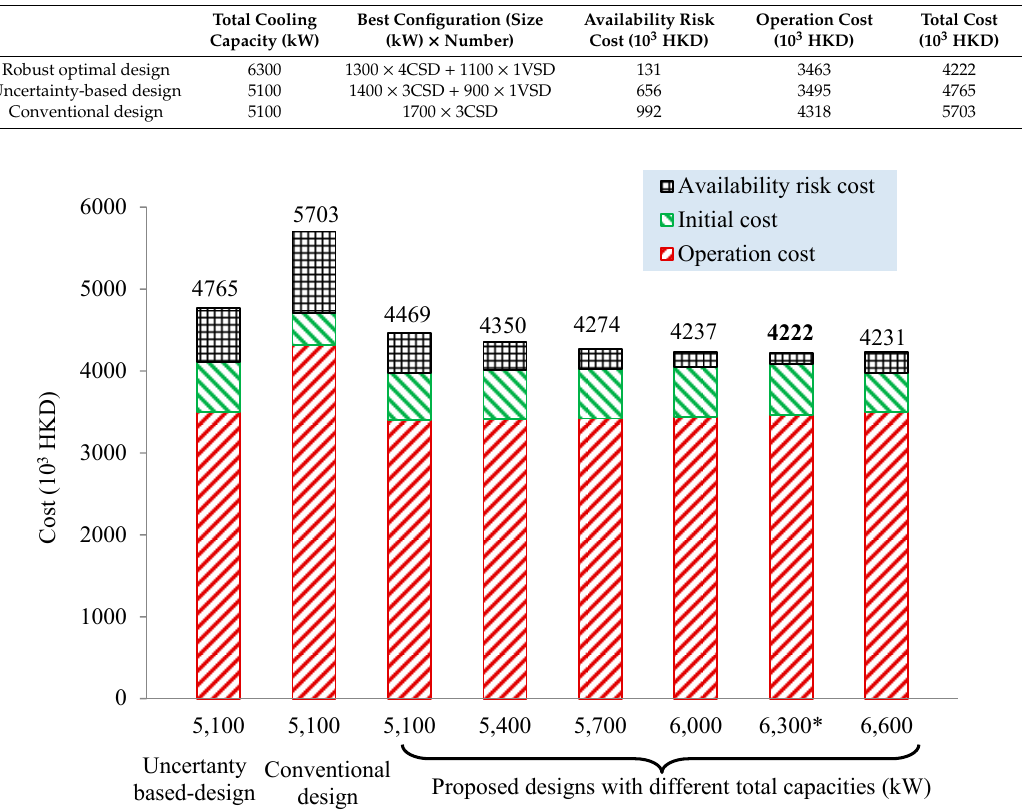
Table 8. Optimal configurations using di ff erent design methods (penalty ratio: 10 HKD / kW).